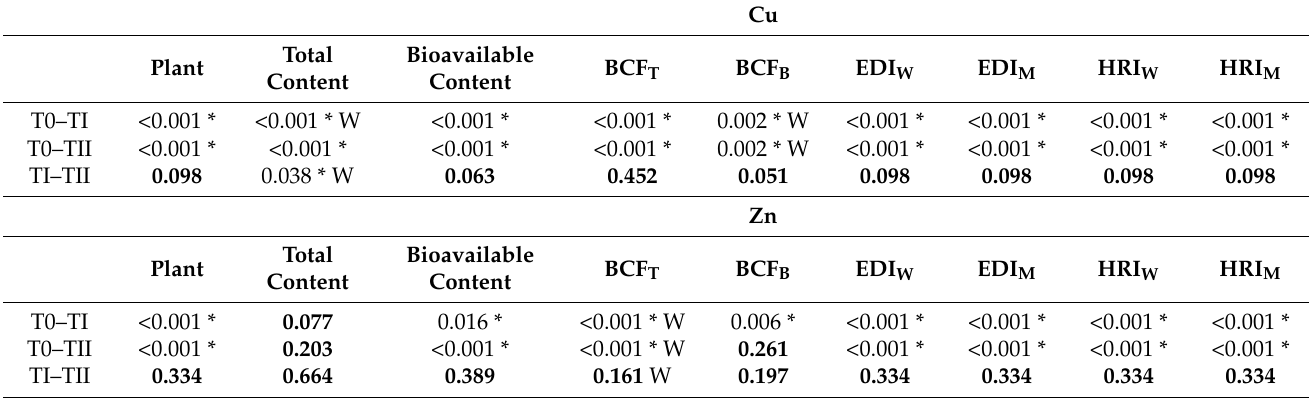
Table 2. The p -values from the comparisons of Cu and Zn contents in camelina, soil, and other parameters depending on the applied amendments (compost—TI and fly ash—TII) and their absence